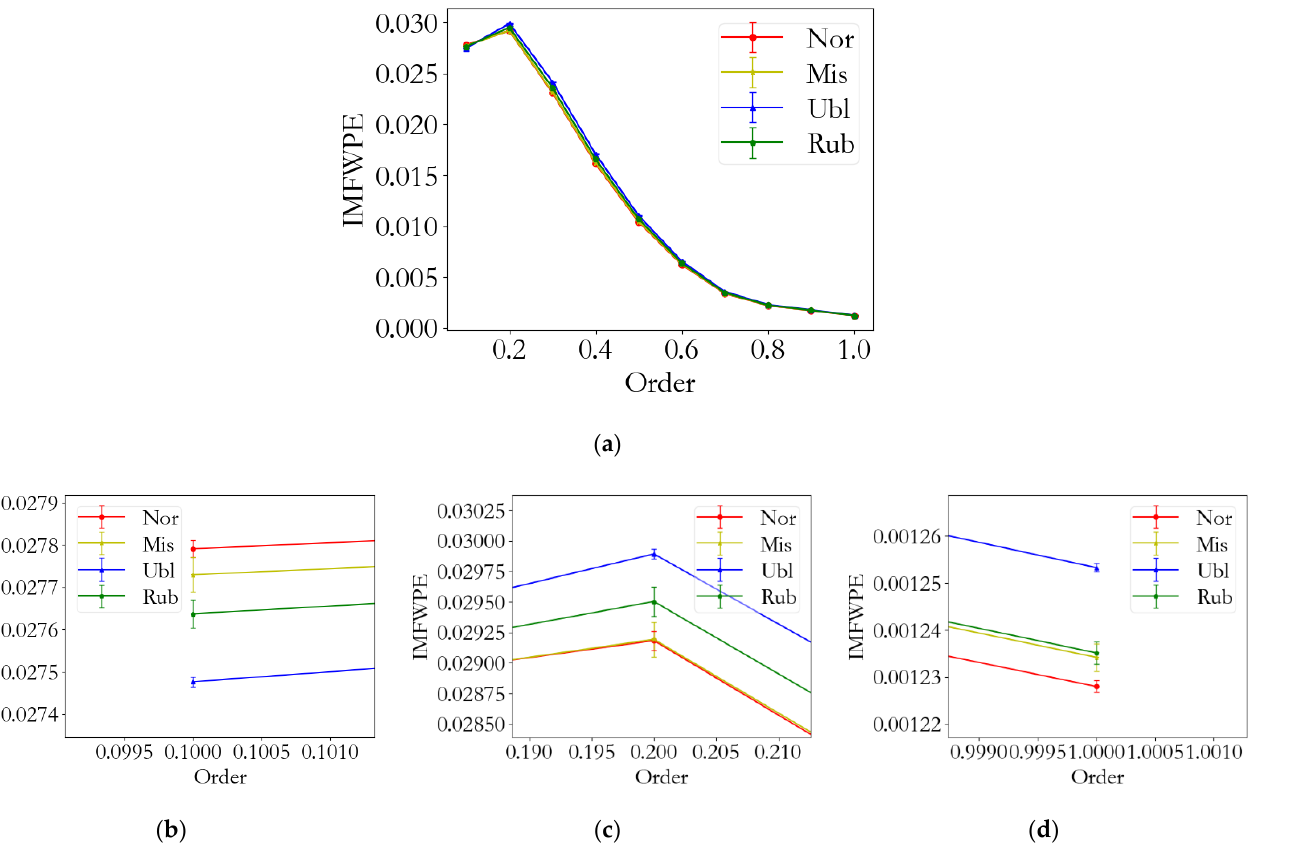
Figure 7. IMFWPE entropy values of vibration signals at different orders: ( a ) entropy distribution of vibration signal at different orders; ( b ) entropy distribution of 0.1 order signal; ( c ) entropy distribution of 0.2 order signal; ( d ) entropy distribution of 1 order signal.